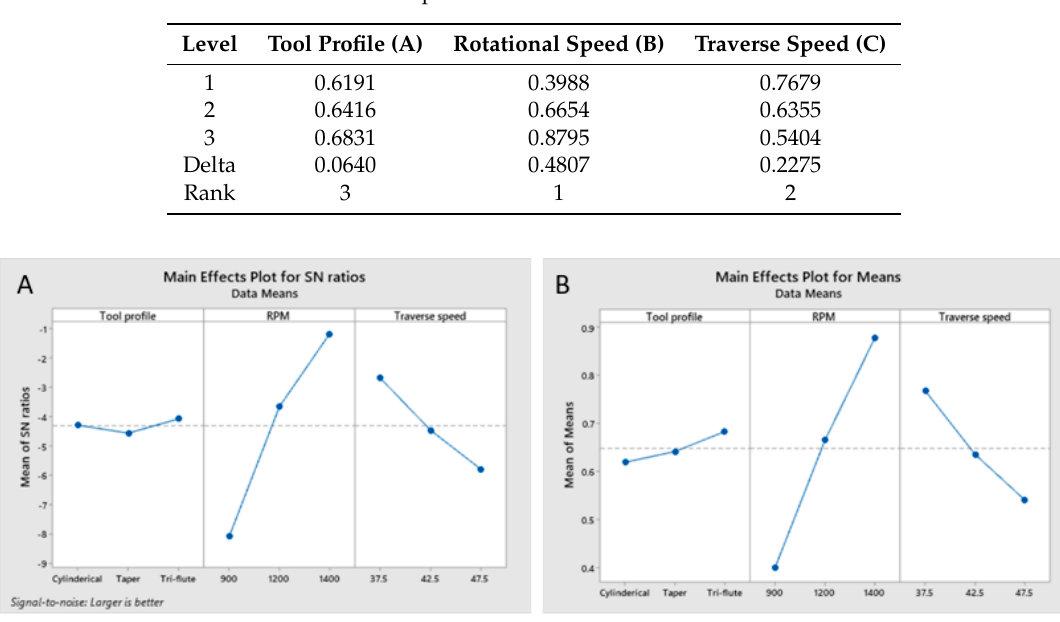
Figure 11. ( A ) Signal to noise ratio of Grey relational grade (GRG) ( B ) Main effects of Grey relational grade (GRG). Table 16. Response table of main effects for GRG.